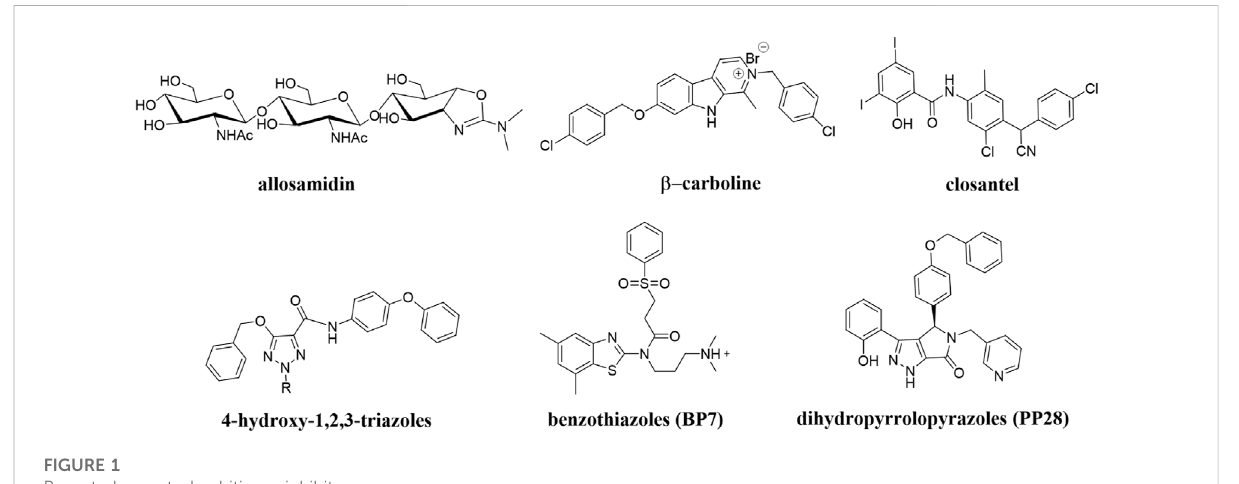
FIGURE 1 Reported nematode chitinase